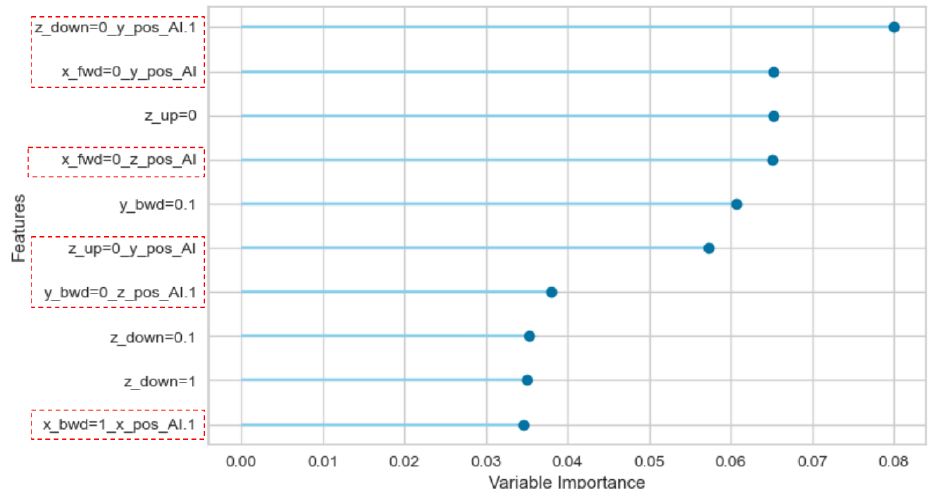
Figure 8. DPick And Place: Feature Importance regarding the PA dataset.